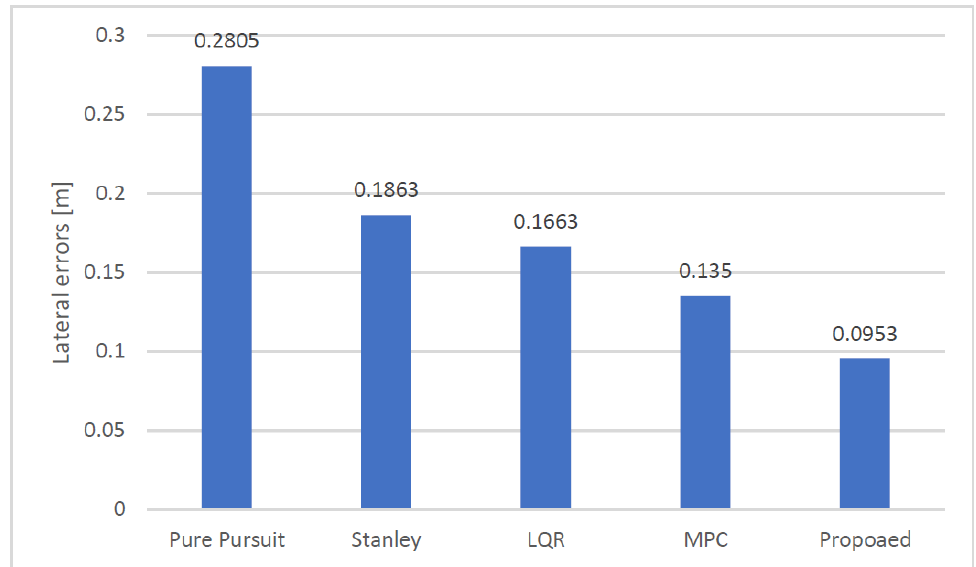
Figure 17. Average lateral error comparison of the different trajectory tracking